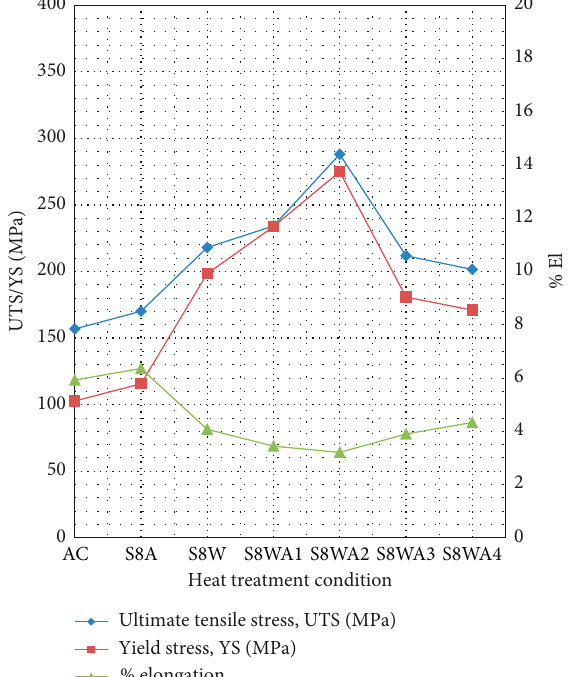
Figure 10: Average values of UTS, YS, and %El obtained at 250 ° C, for alloy E in the as-cast condition, and after heat treatments comprising SHT for 8